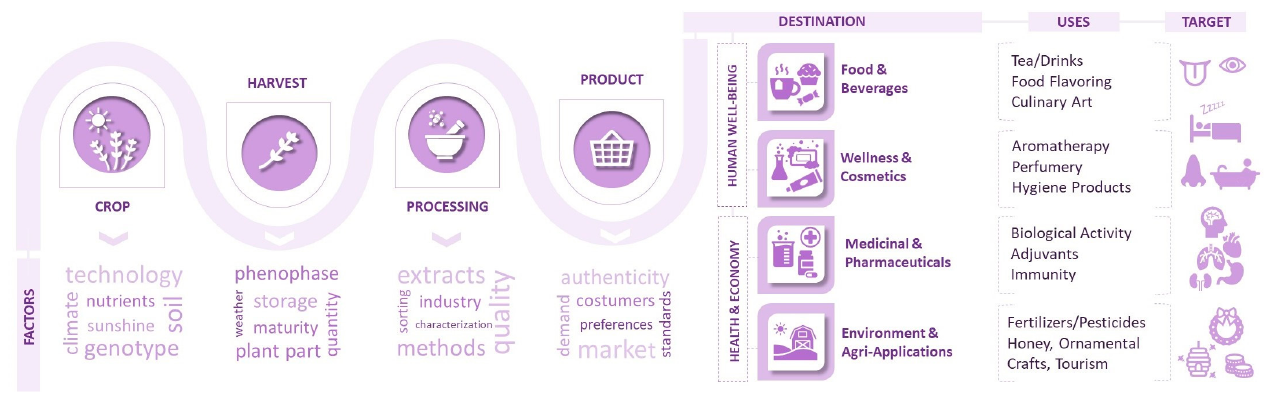
Figure 3. Lavender from crop to products with an overview on the main uses as they are related to human senses, activities and favorable outcomes (original infographic by Ioana C.).